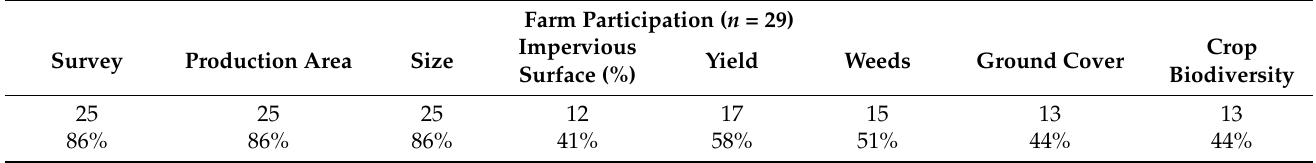
Table A2. Farm participation in research (not all farms participated in all aspects of this survey). Farm Participation ( n = 29)